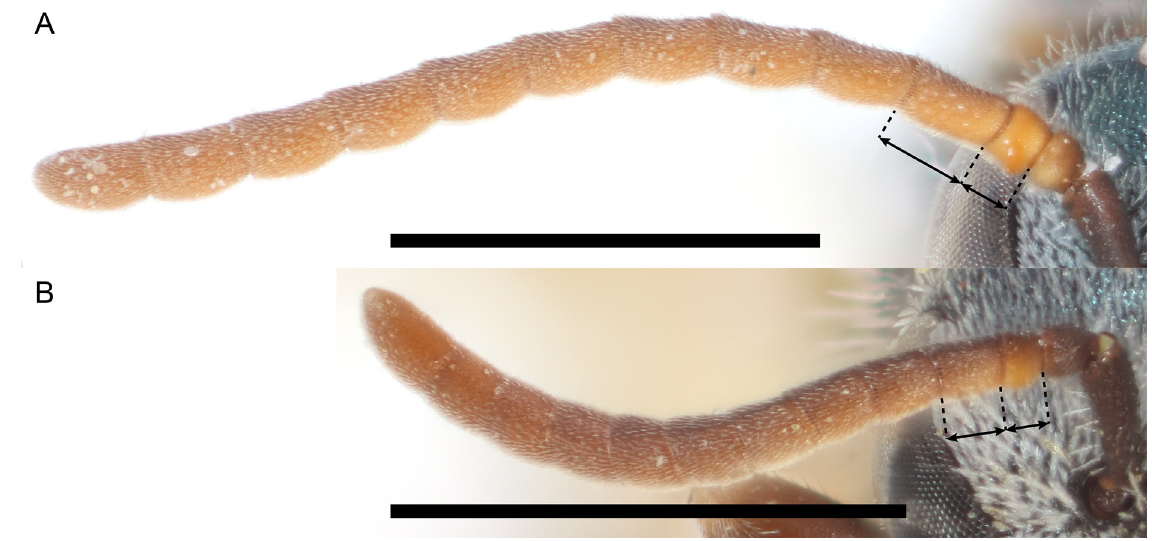
Fig. 115. Flagellomeres. A . Lasioglossum ( D. ) festinum sp. nov., ♂, long. B . L. ( D. ) imbriumbrae sp. nov., ♂, short. Scale bars: 1 mm. Arrows indicate relative lengths of F1 and